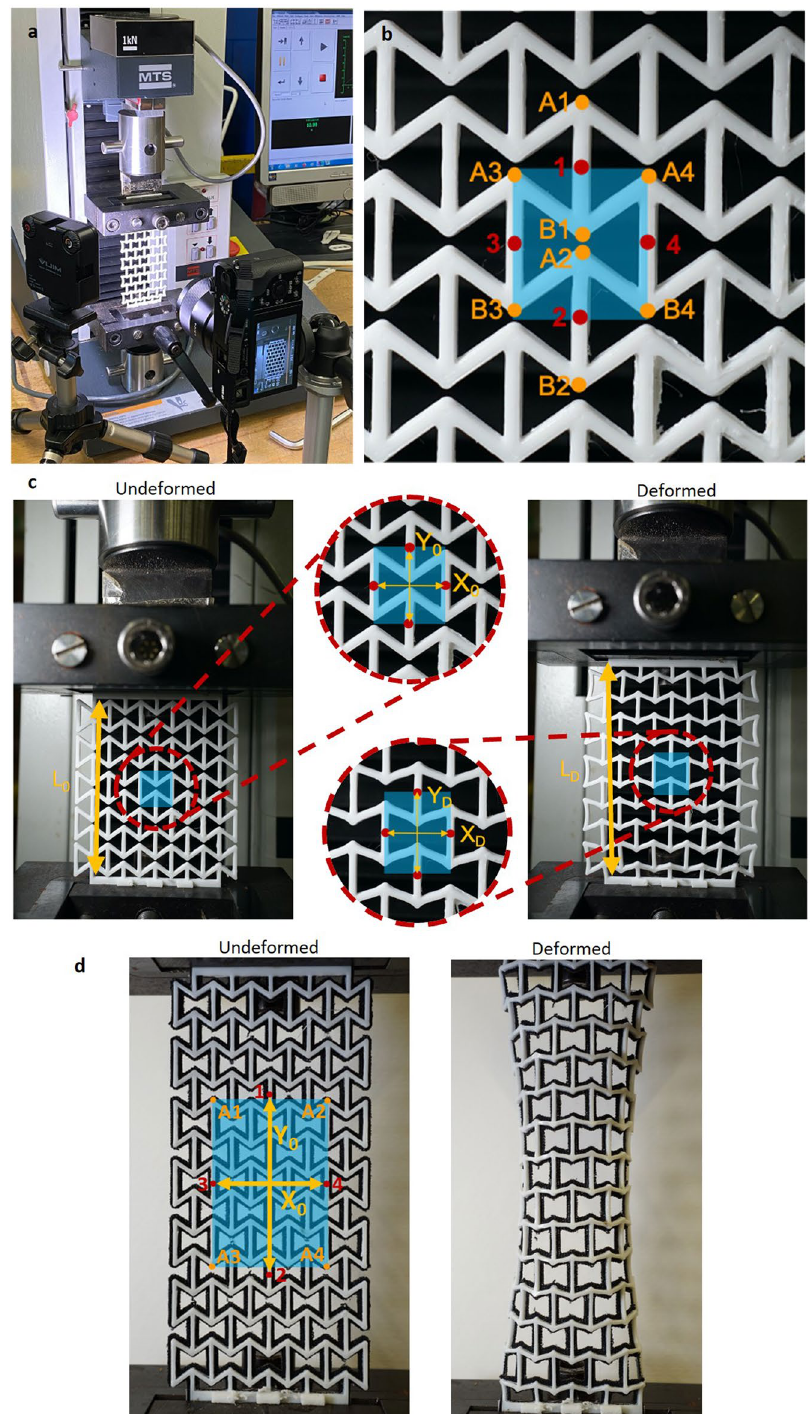
Figure 8. Mechanical characterization and data analysis. ( a ) Tensile test setup for the mechanical characterization. ( b ) Data analysis: the Poisson’s ratio is determined for the highlighted central unit cell. The coordinates of relevant points (labeled as A i and B i , i = 1, 2, 3, 4) are computed in pixels, from which the coordinates of the middle point of each vertical beam (labeled simply using numbers from 1 to 4) are calculated. ( c ) Undeformed and deformed auxetic structure in the tensile test measurement device: X 0 , Y 0 , X D and Y D are used to calculate the Poisson’s ratio at the given strain, determined using the L 0 and L D measurements. ( d ) Undeformed and deformed auxetic KT. The points analyzed for this second experiment are also